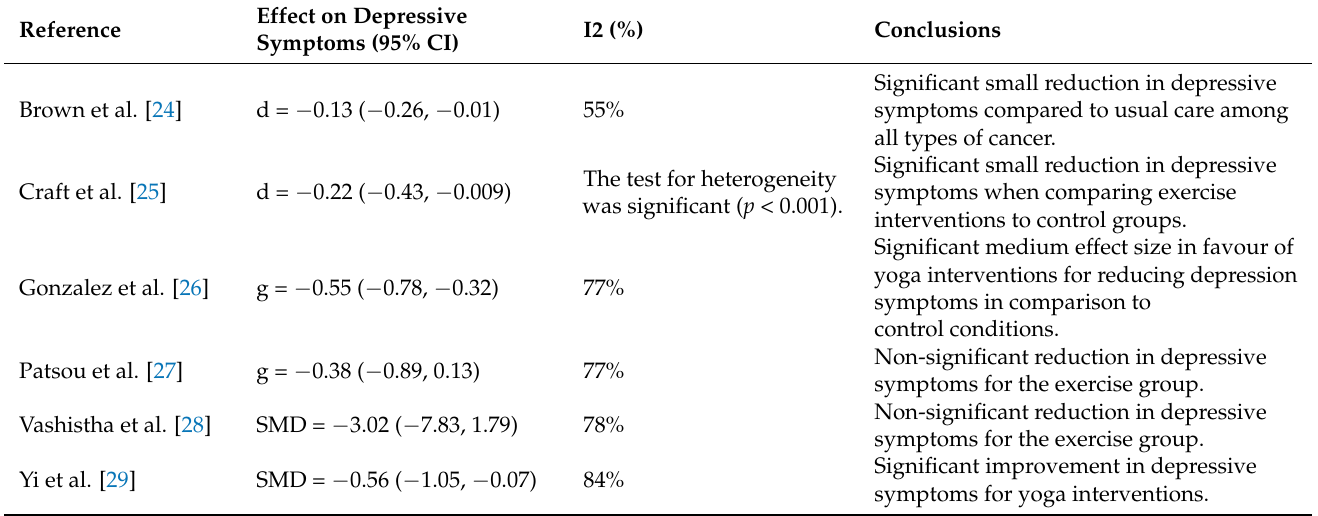
Table 3. Results of the meta-analyses included in the